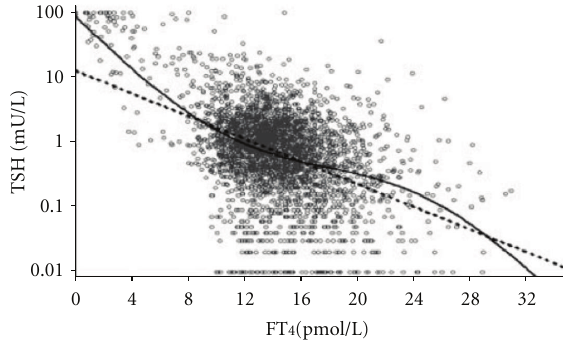
Figure 3: Comparison of a nonlinear model with the log linear standard model in a large clinical data set. The superior fit of the non-linear model was proven by comparative curve fitting, as shown in [26]. The figure is reprinted by permission of the publisher Bioscientia (http://www.eje-online.org/site/misc/permis- sions commercial